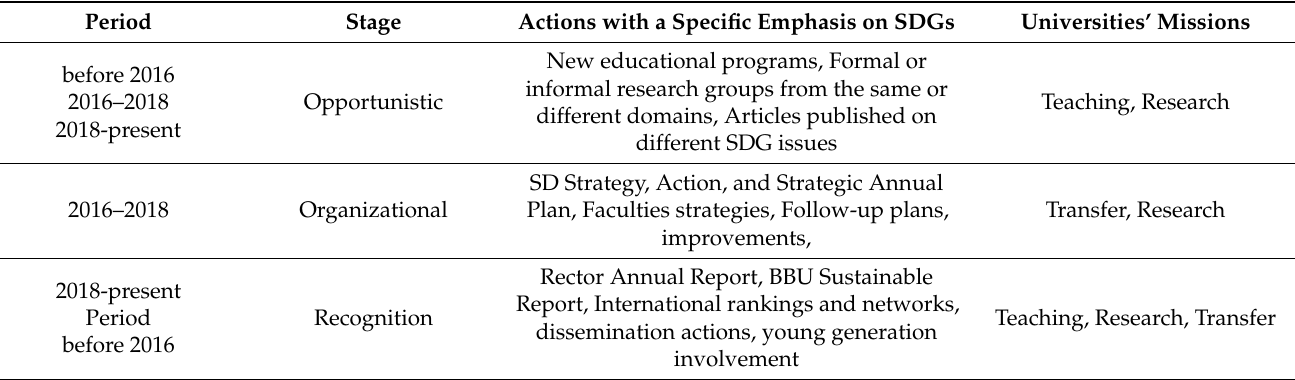
Table 2. Stages of the BBU and SD